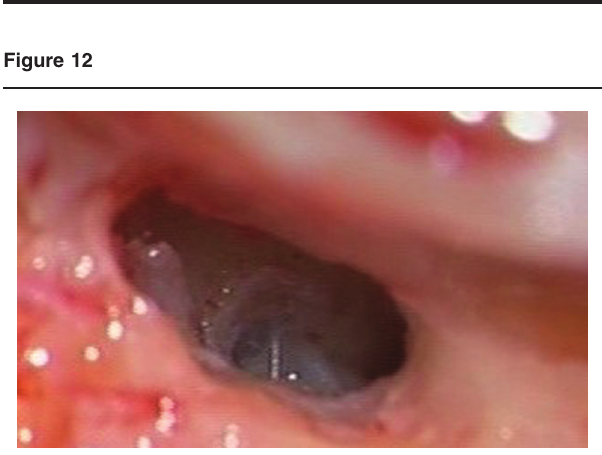
Slit visible RWM in another patient. RWM, round window membrane.